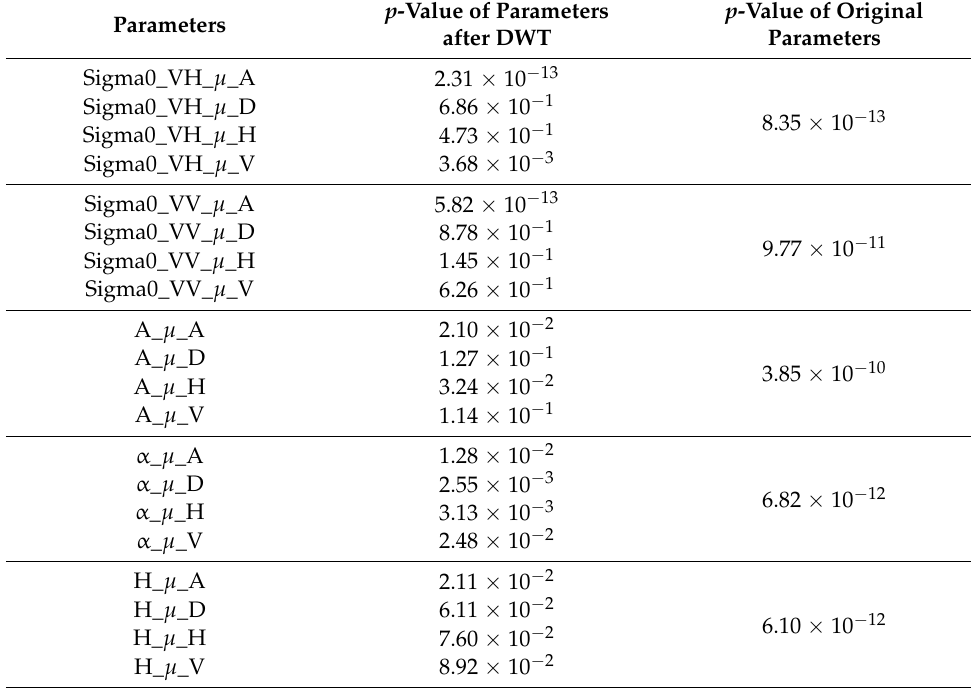
Table A1. p -value of the original parameters and all components after DWT. Letter A after the parameters indicates the low-frequency component after DWT. Letters H, V, and D after the parame- ters represent the horizontal component, vertical component, and diagonal component after DWT,